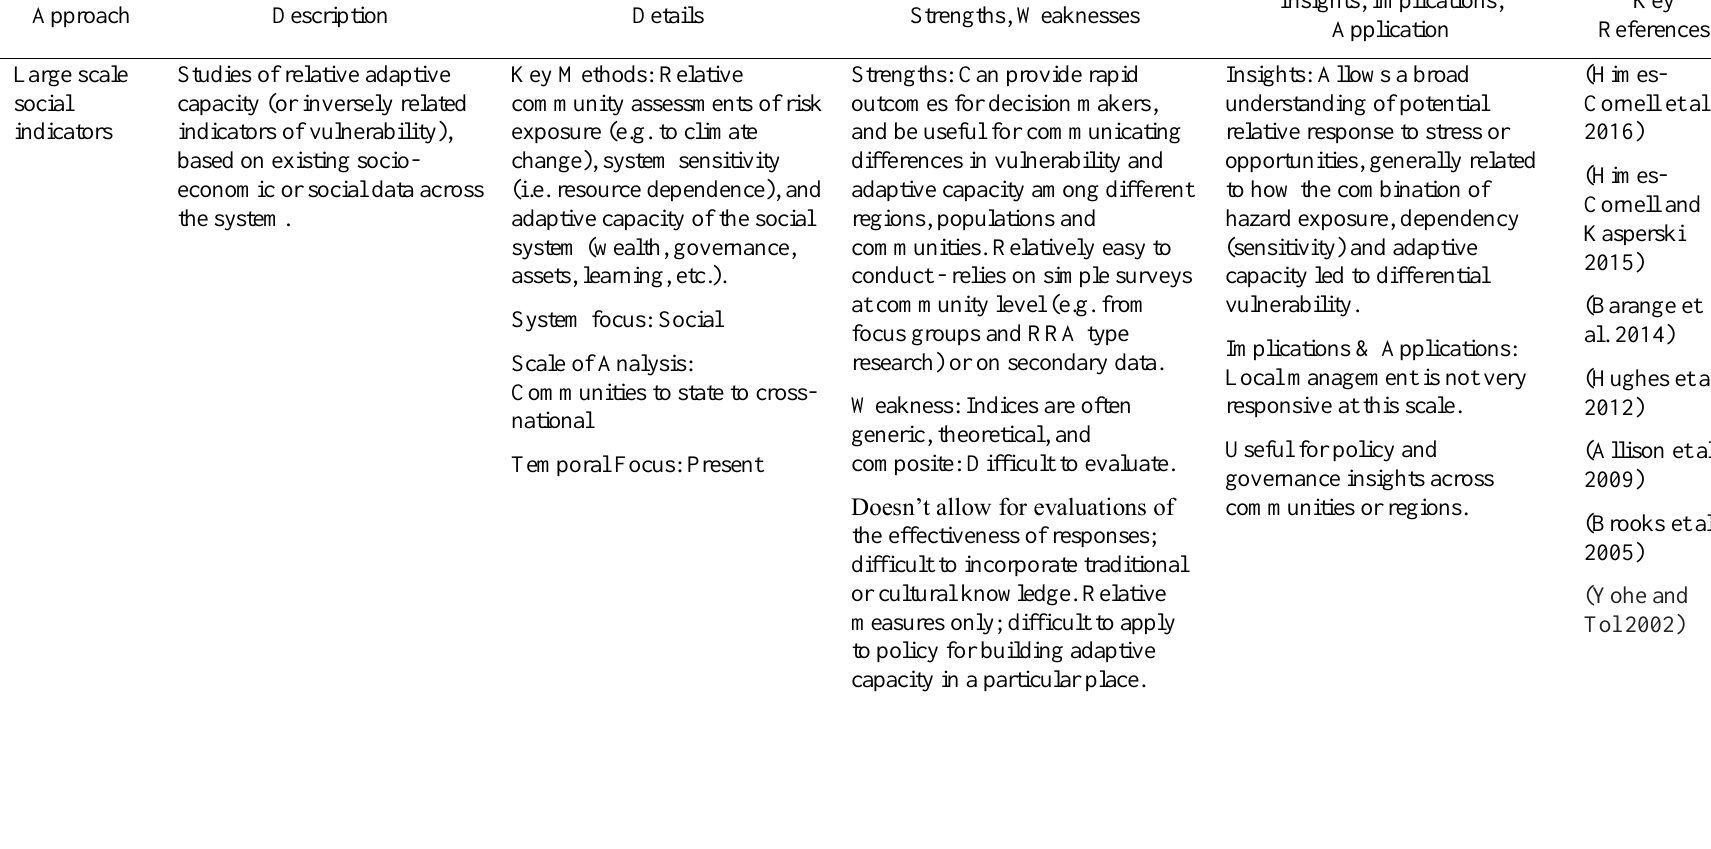
included of case study examples and reviews for each method, where